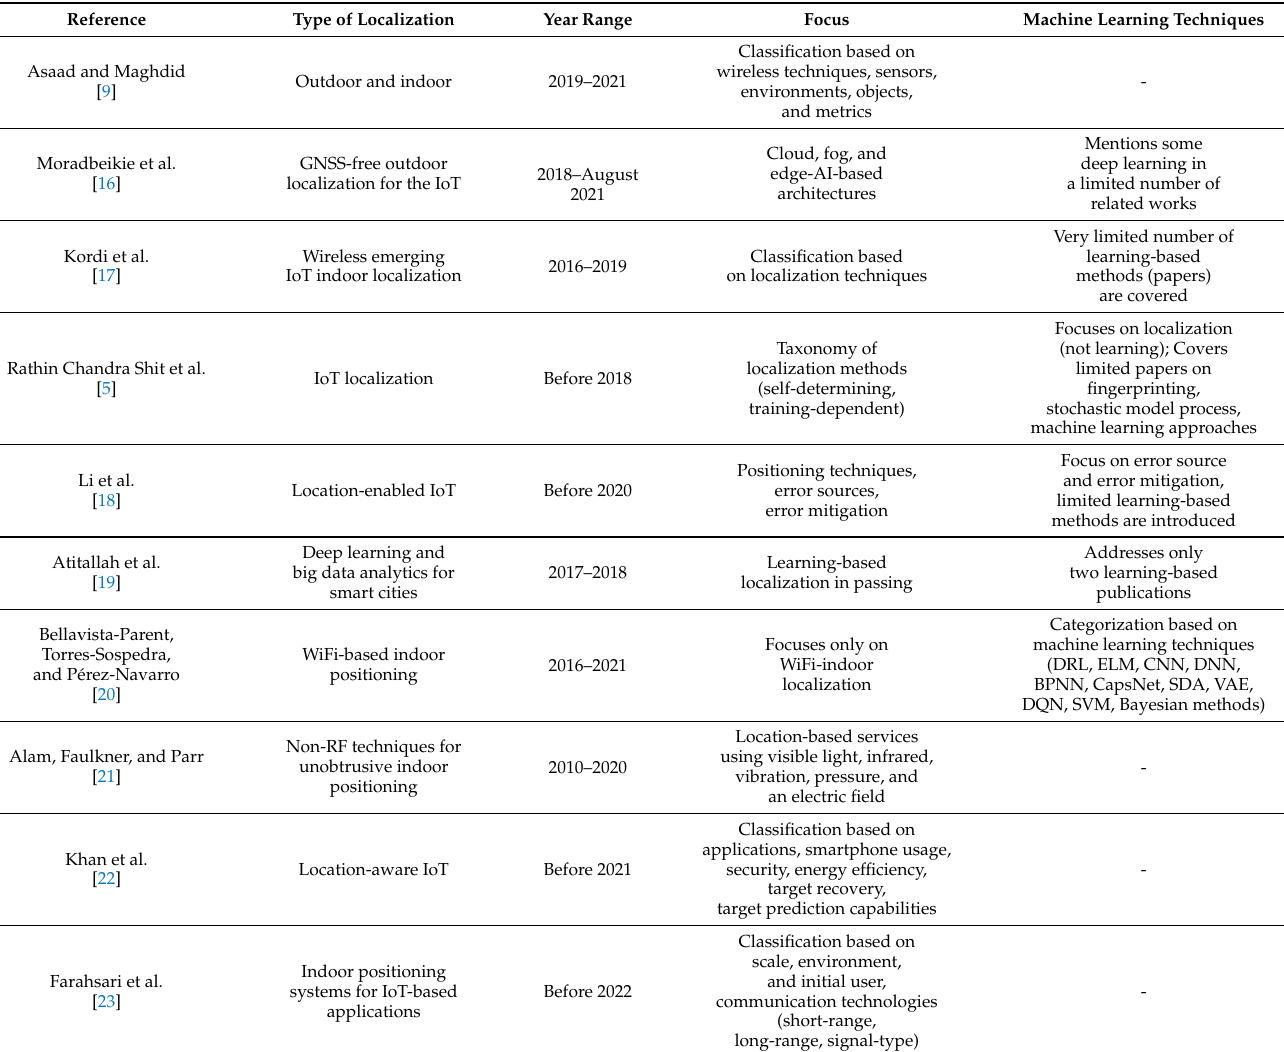
Table 1. A summary of existing surveys, organized by type of localization, year range, focus, and machine learning techniques